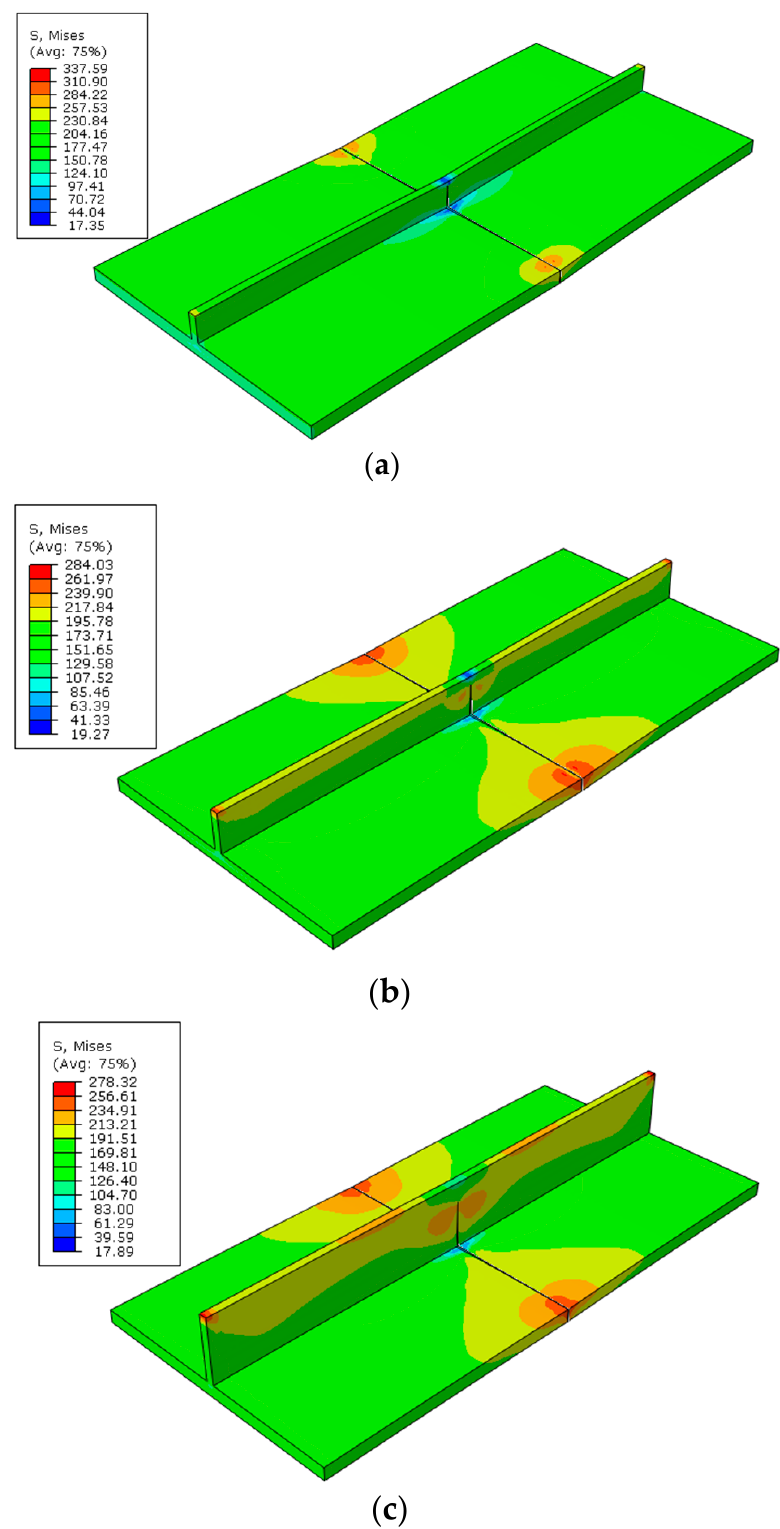
Figure 16. Stress contour plots for uniaxial tensile model in different stiffener sizes; ( a ) h w = 20 mm, RF = 399.5 kN; ( b ) h w = 30 mm, RF = 421.7 kN; ( c ) h w = 50 mm, RF = 450.7 kN. (Unit: MPa.)